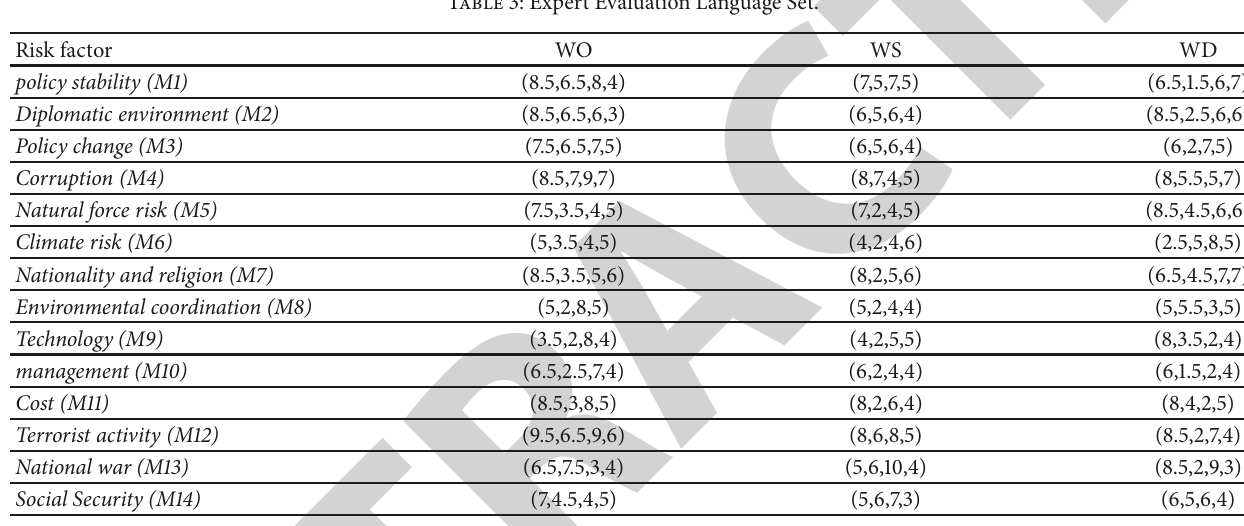
Table 3: Expert Evaluation Language